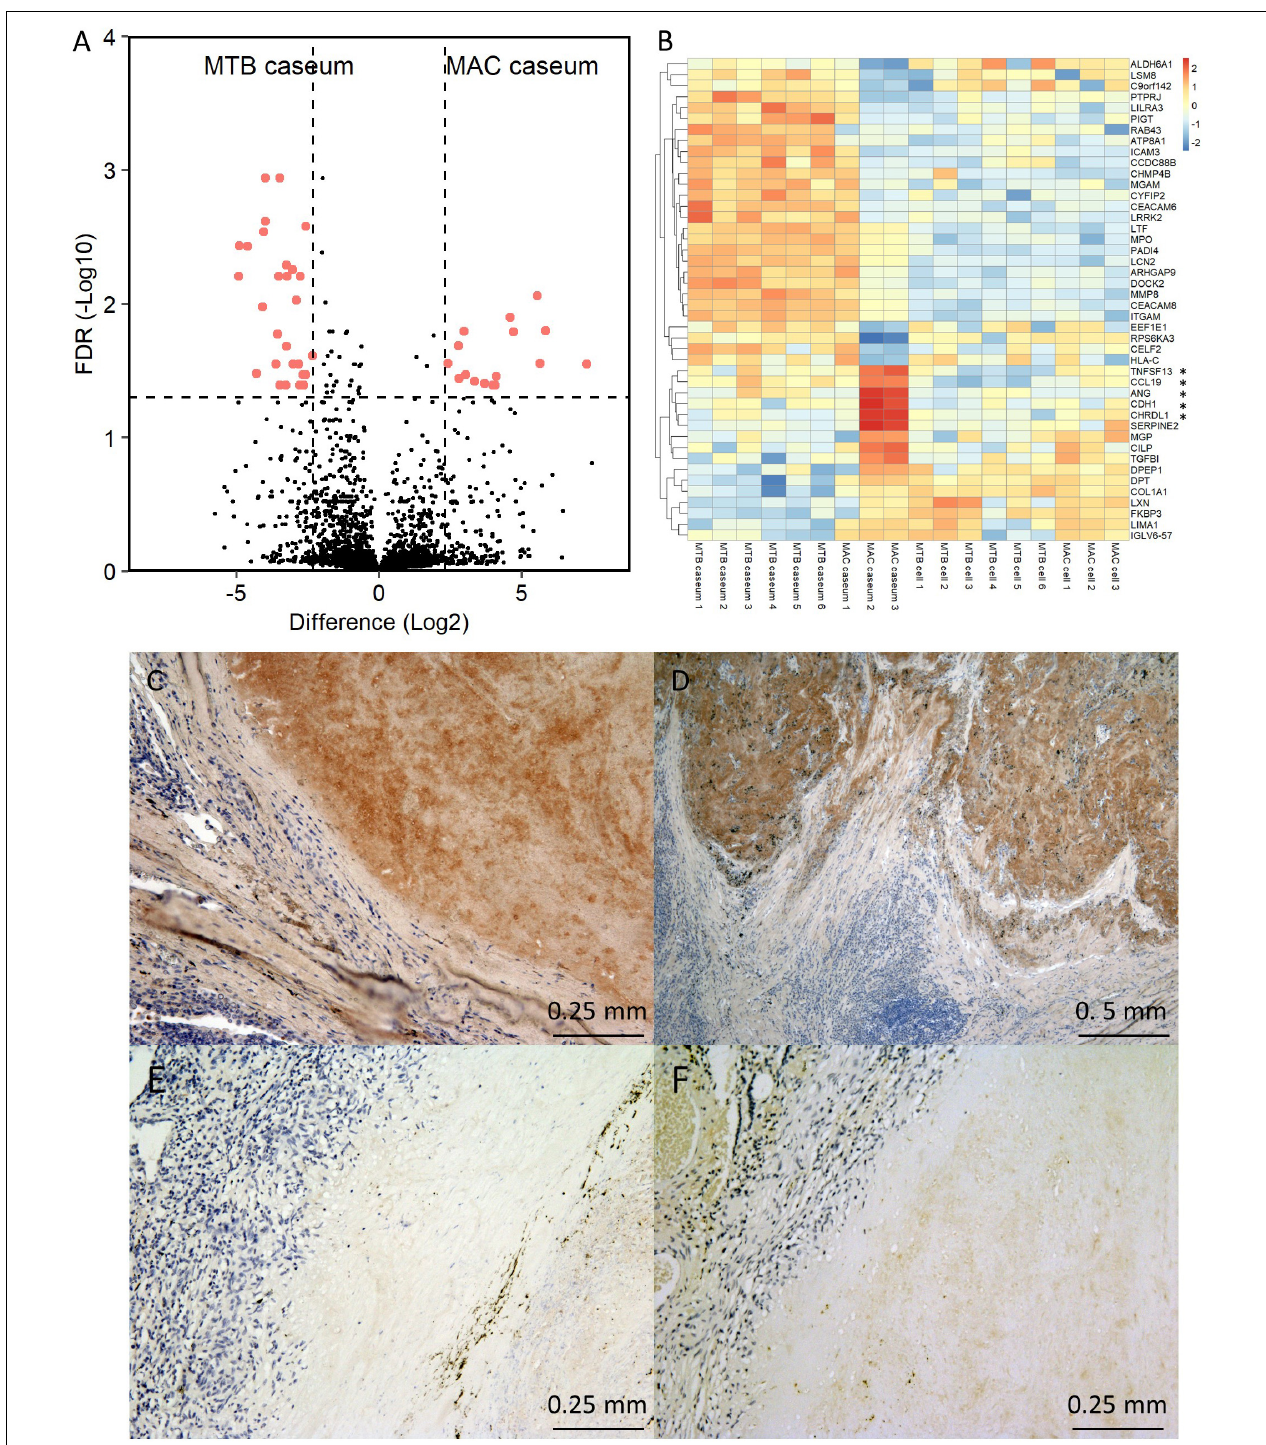
FIGURE 6 | Heterogeneity of MAC-LD granulomatous lesions. (A) Volcano plot of protein abundance between TB caseum and selected MAC-LD caseum. The logarithmic ratios of average fold changes and negative logarithmic FDR values of the Welch’s t -test between samples from TB caseum and selected MAC-LD caseum are plotted on the x- and y -axes, respectively. Highlighted dots correspond to proteins with significantly different abundance (FDR < 0.05 and absolute value of fold change > 5). (B) Hierarchical-clustering-based heat map for proteins with significantly different abundance between TB caseum and selected MAC-LD caseum ( n = 44). Protein names with significantly different abundance in the caseous sub-compartments from TB or MAC-LD are indicated. ∗ Proteins with significant abundance in the selected MAC-LD caseum ( P < 0.05, Tukey–Kramer post hoc test following one-way ANOVA). Immunohistochemistry of Angiogenin in granulomatous lesions of selected MAC-LD (C,D) , non-selected MAC-LD (E) and TB (F) .